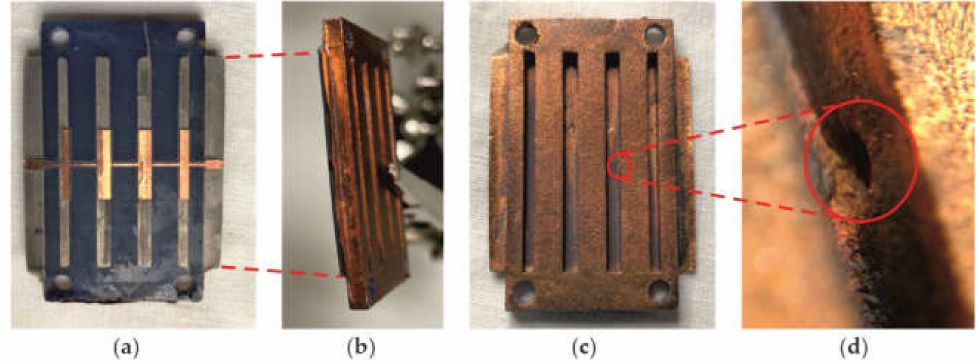
Figure 15. Circuit under analysis: ( a ) top surface; ( b ) details of delamination in the boundary; ( c ) bottom surface; ( d ) details of